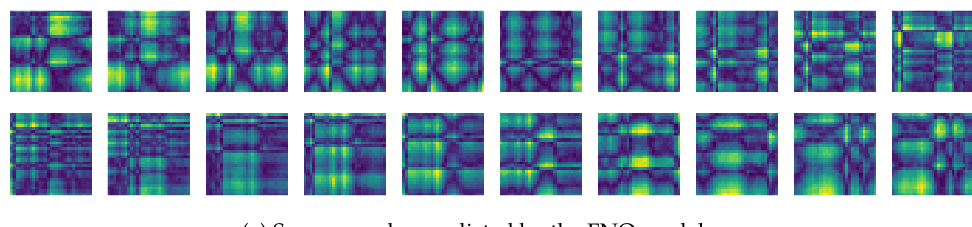
( a ) Some samples predicted by the FNO model.